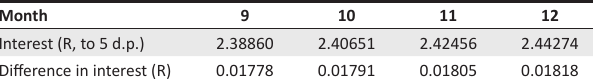
TABLE 4: Amount of interest rounded to five decimal places.